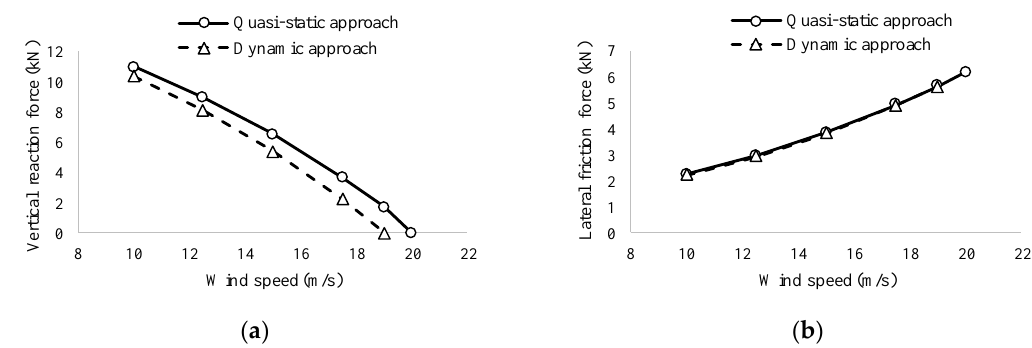
Figure 7. Tire forces of the trailer in uniform wind: ( a ) vertical reaction force of windward wheel, ( b ) lateral friction force.